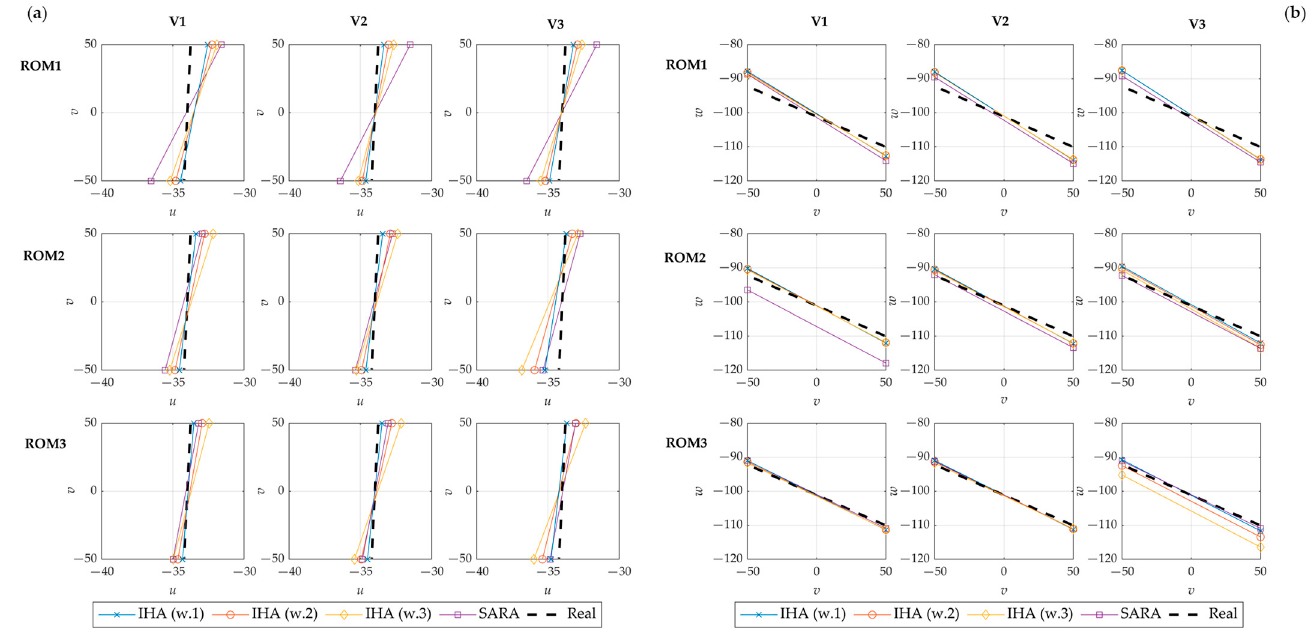
Figure 6. AoRs calculated with MHA, by choosing different weighting factors, and SARA, for motion configuration D. The axes are represented in two views: ( a ) transverse (horizontal) plane; ( b ) frontal plane. Each row and column correspond to a particular range of motion (ROM) and speed (V) selected, using the same nomenclature detailed in Section 2.3.2. The exact AoR imposed by joint kinematics setup is highlighted in dashed black line. All axes units are in